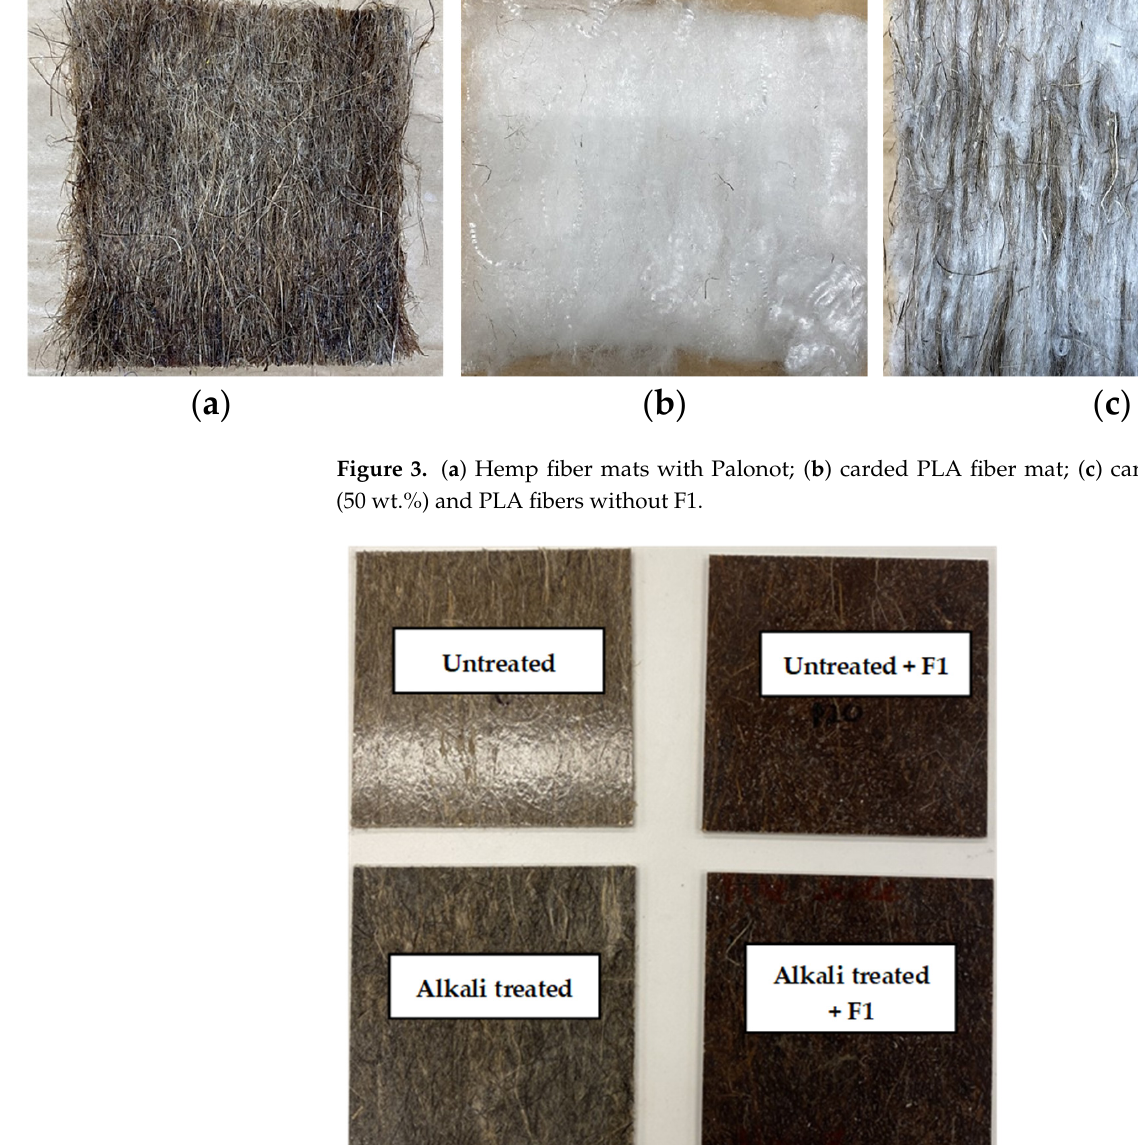
Figure 3. ( a ) Hemp fiber mats with Palonot; ( b ) carded PLA fiber mat; ( c ) carded mix of hemp (50 wt.%) and PLA fibers without F1.